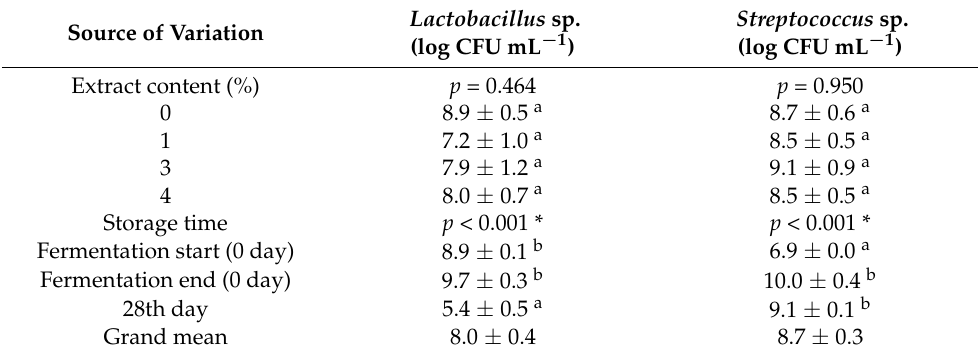
Table 4. Influence of extract content (0, 1, 3 and 4%) and storage time (fermentation start and end and 28th day) on the Lactobacillus sp. and Streptococcus sp. (log CFU mL − 1 ) counts. Source of